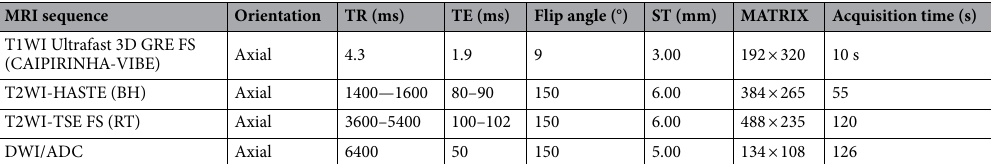
Table 5. MRI sequences and parameters. TR/TE repetition time , TE echo time , BH breath-hold , RT respiratory-triggered , DWI diffusion weighted image , IP/OP in-phase/opposed-phase, VIBE volumetric interpolated breath-hold sequence, GRE gradient-recalled echo, FS fat suppression, CAIPIRINHA controlled aliasing in parallel imaging results in higher acceleration, HASTE half-Fourier acquisition single-shot turbo spin-echo, TSE turbo spin